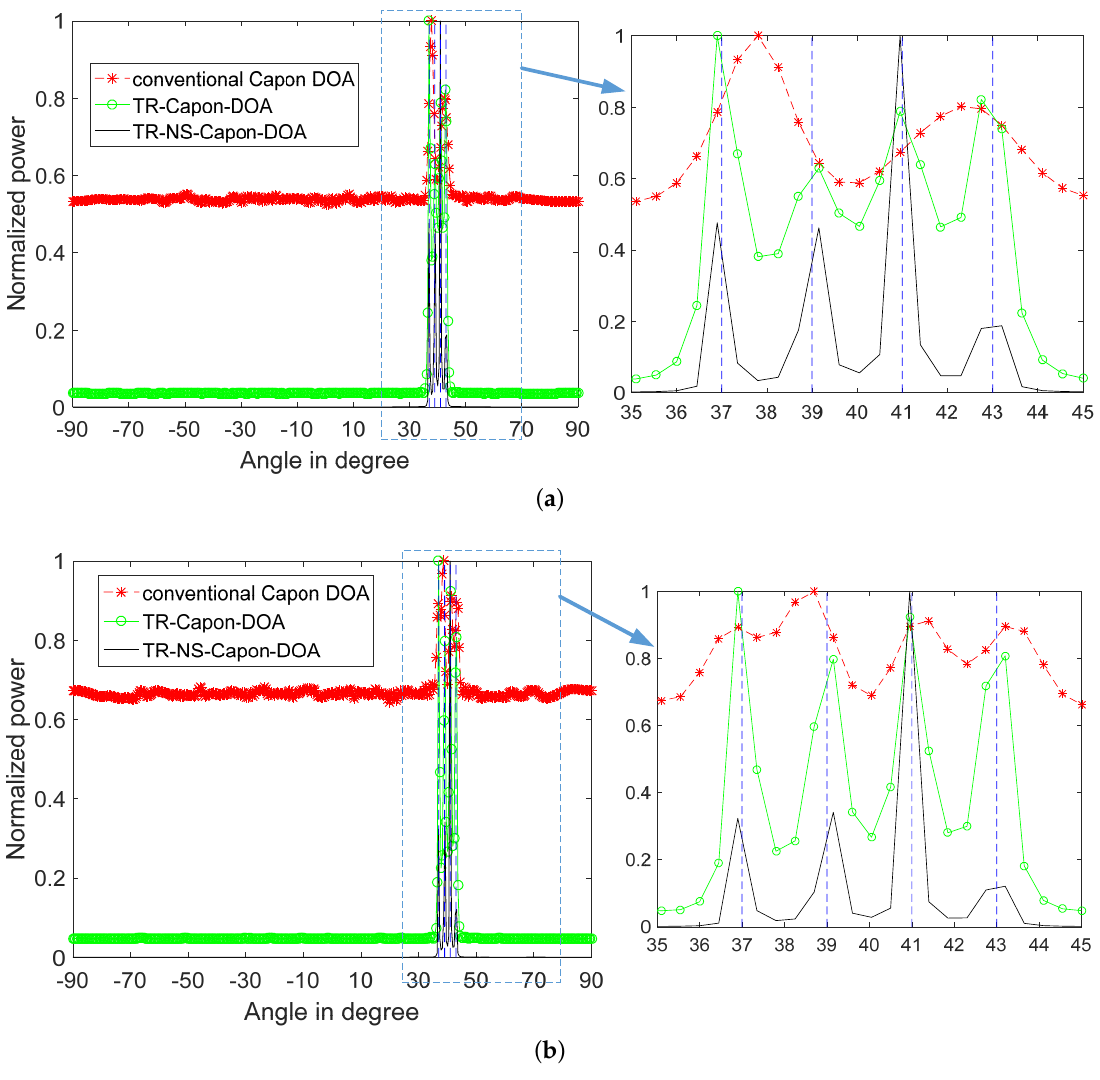
Figure 13. 4-path normalized power spectra versus angles for conventional Capon DOA, TR-Capon-DOA and TR-NS-Capon-DOA algorithms under the condition of LFM used as ES, SNR = − 15 dB and ( a ) conventional CA ( b ) Optimized